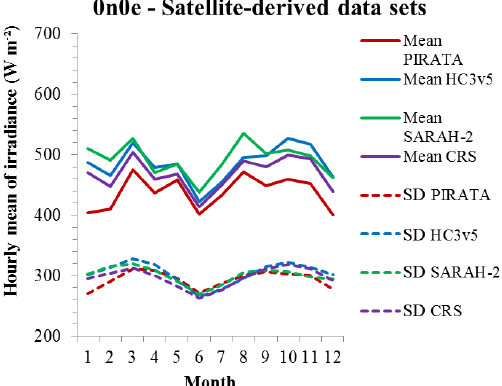
Figure A3. Monthly means (solid lines) and standard deviations (dotted lines) of hourly DSIS, in Wm − 2 , from PIRATA measurements (red) and data sets (HC3v5: blue, SARAH-2: green, CRS: purple) at 0 ◦ N, 0 ◦ E. A difference between red line (measurements) and coloured line (data set) for a given month denotes a systematic error for this month: underestimation if the coloured line is below the red line, overestimation otherwise. For a given month, a coloured dotted line above the red one means that the data set produces too much variability for this month; in the opposite case, the data set does not contain enough